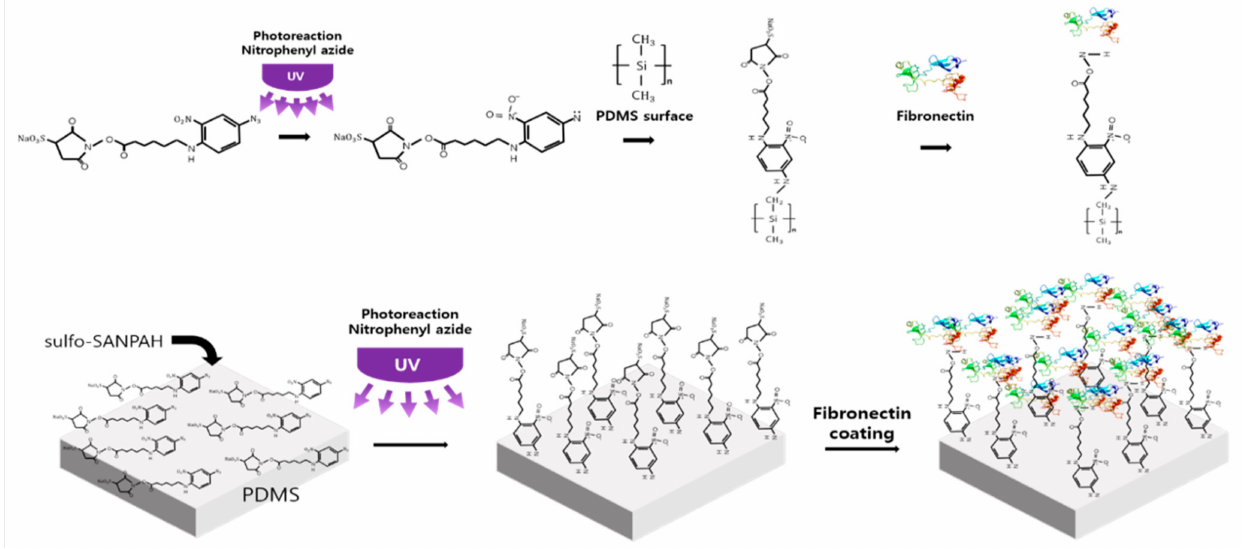
Figure 9. Schematic diagrams for a binding process of sulfo-SANPAH, Fibronectin and